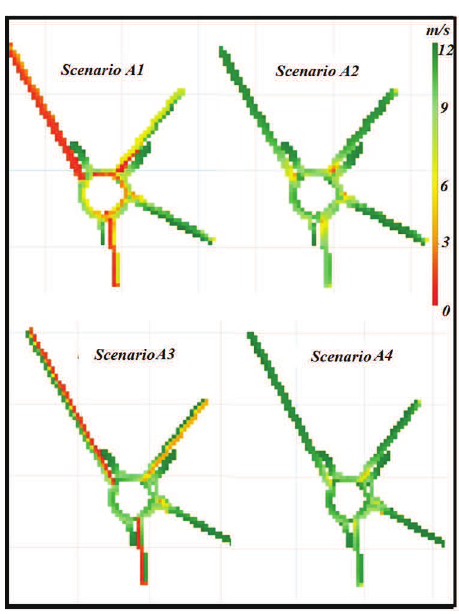
Fig. 7. Resulting average speed of vehicles for considered scenarios